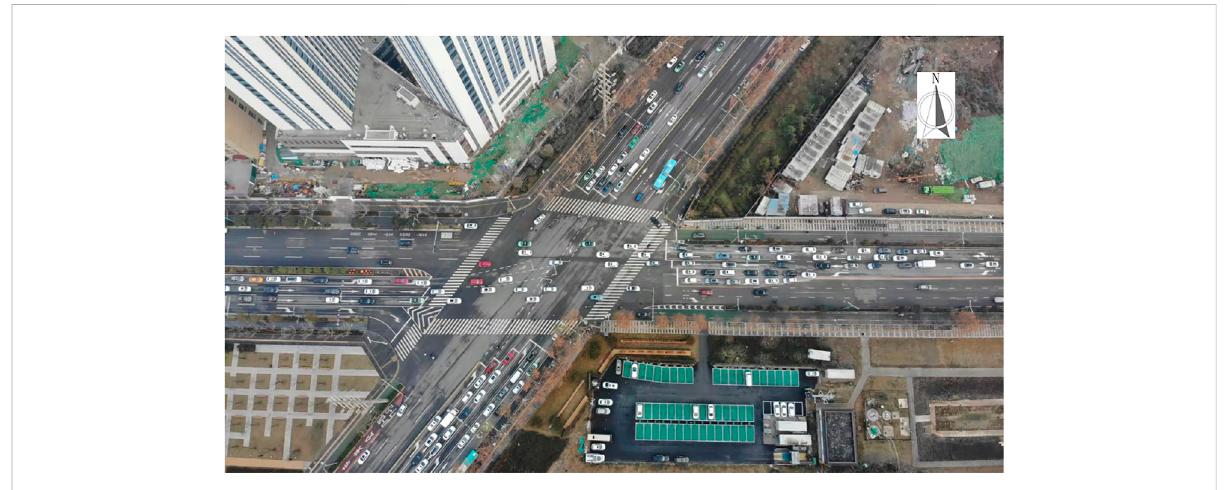
FIGURE 4 The present situation of the signalized intersection. An unconventional outside left-turn lane is located in the fourth lane of the South entrance direction of the intersection. Coordinates: 108.896818, 34.206657.